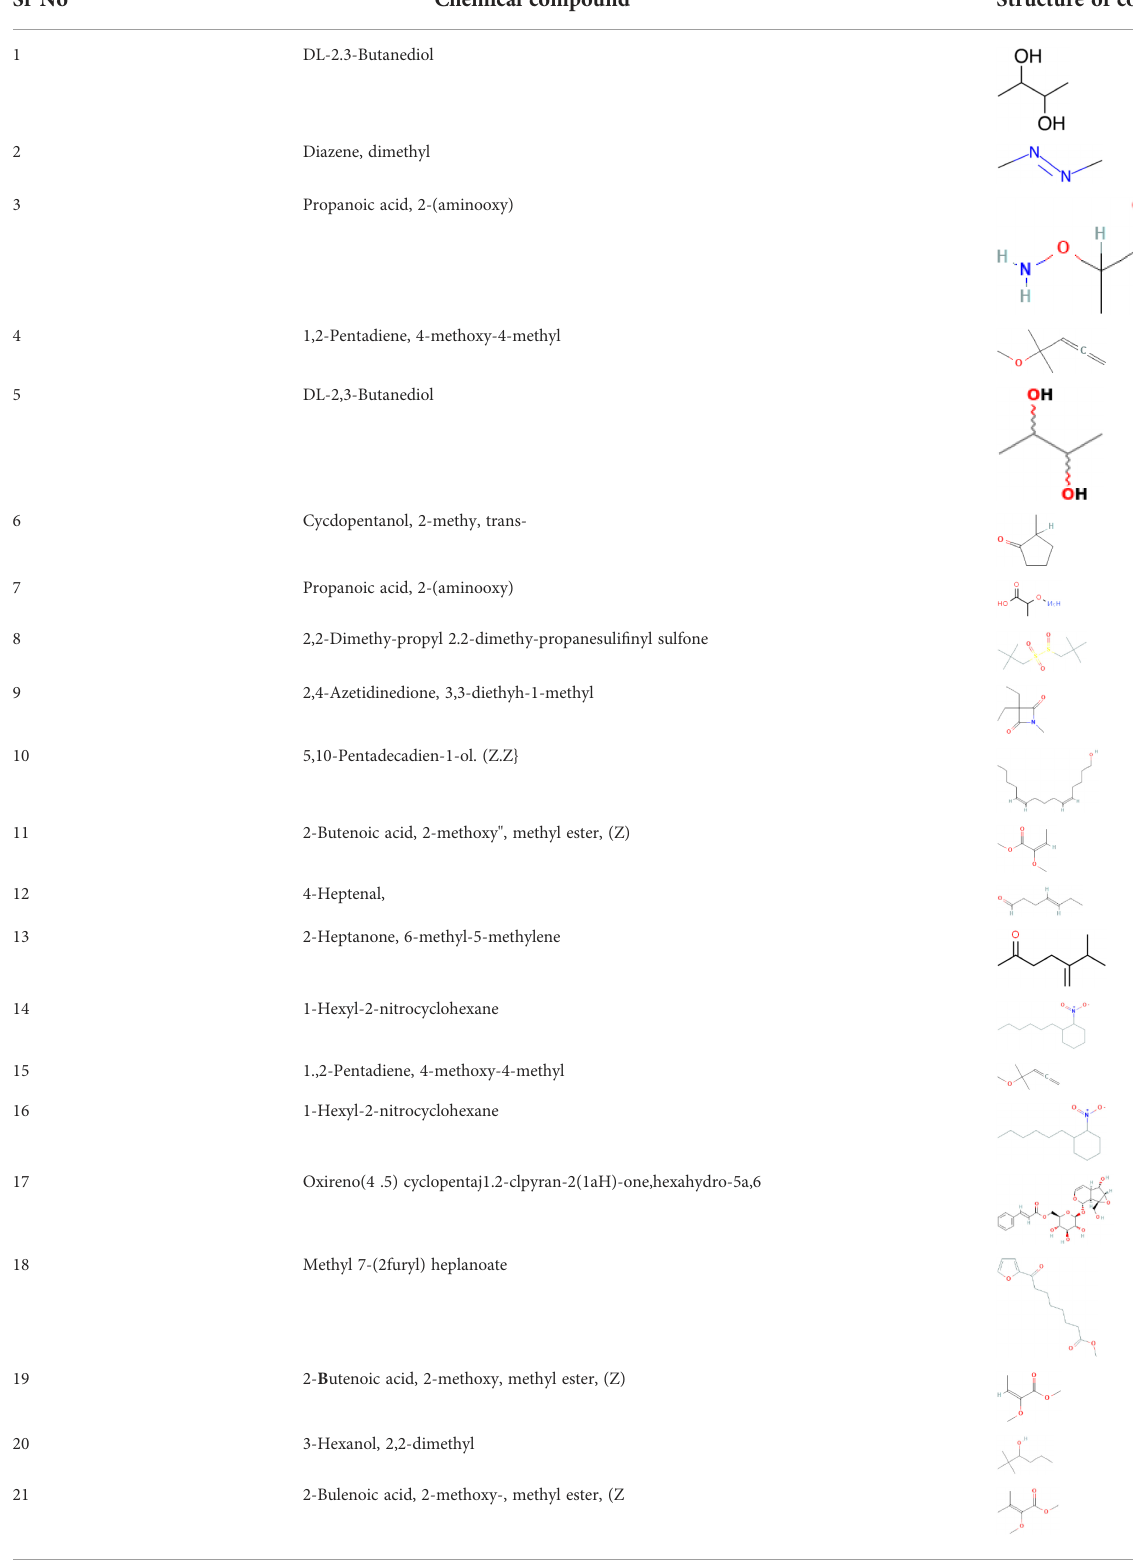
TABLE 2B Chemical compounds structure of Sargassum sp. extract by GCMS pro fi ling. Sr No Chemical